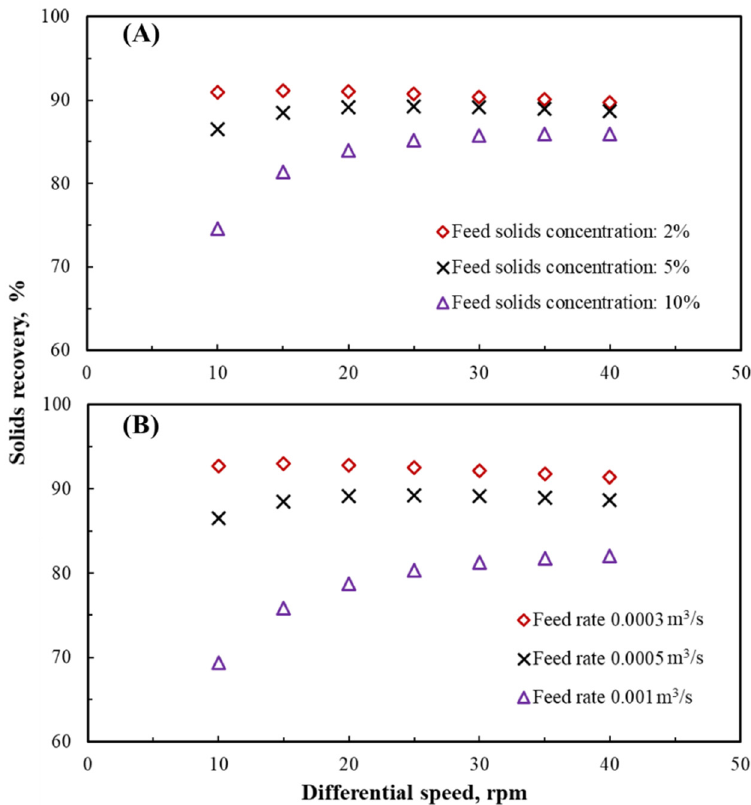
Figure 5. The relationship between the differential speed and solids recovery: ( A ) with three feed solids concentrations, feed rate at 0.0005 m 3 /s and ( B ) with three different feed rates, feed solids concentration at 5%.